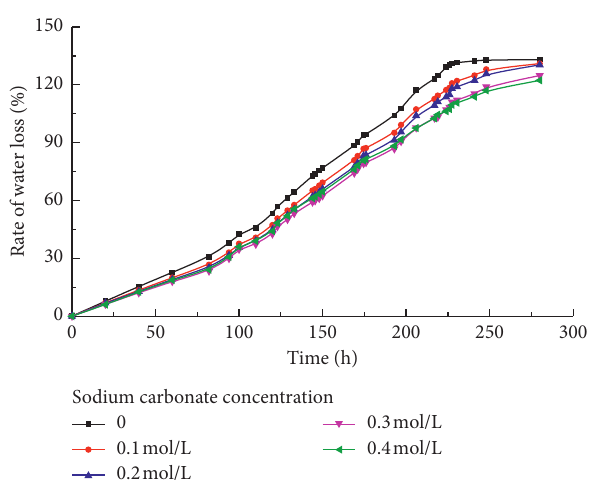
Figure 5: Relationship between the crack ratio and the number of cracking blocks of the